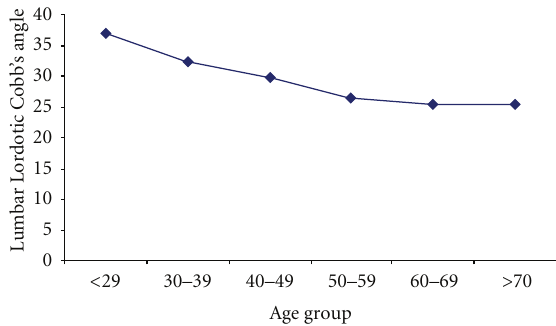
Figure 4: Lumbar lordotic Cobb’s angle and decades of life. The numbers in the figure correspond to the mean angles ( ± SEM) at di ff erent decade of life. It shows a decrease in the magnitude of LLA with age. Figure 5: Number of disc degeneration and age. The numbers in